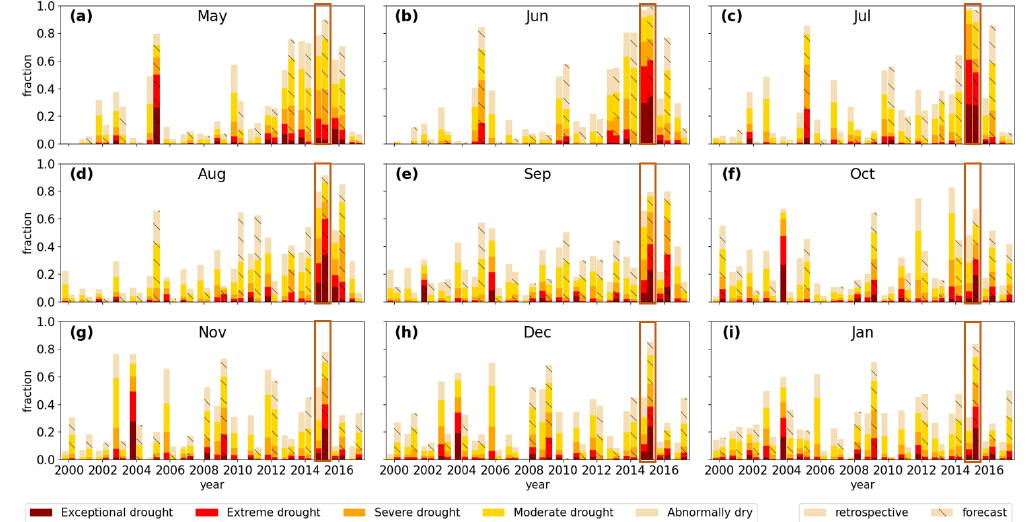
Figure 12. Fractions of areas of different drought categories in Mekong basin calculated using RZSM data from retrospective and hindcast- RIC simulations from (a) May to (i) January.